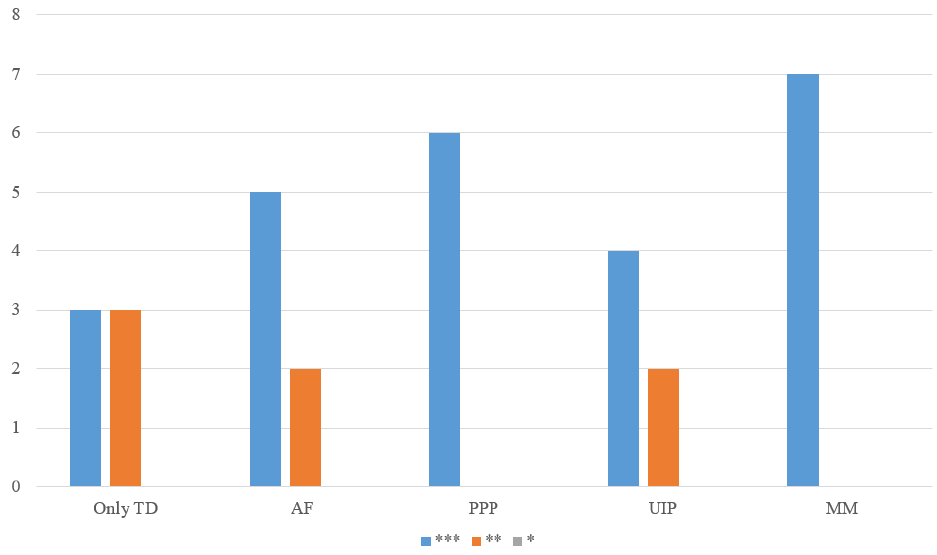
Figure 2. Level of significance—every set of fundamentals vs. only